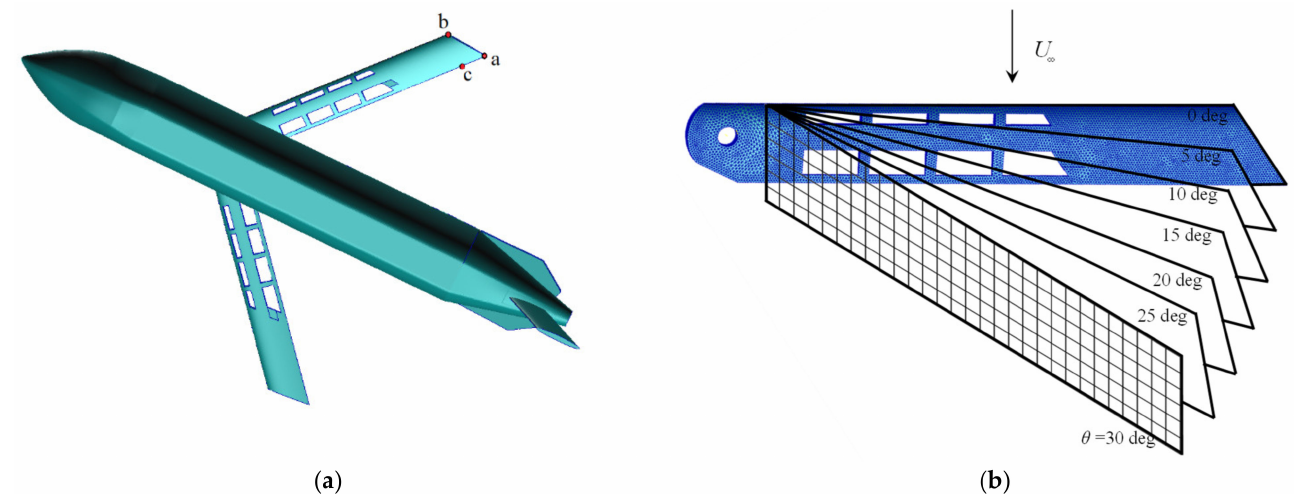
Figure 9. The rotating wing models used for simulations. ( a ) The geometric model of the considered missile. ( b ) The FEM and aerodynamic models.